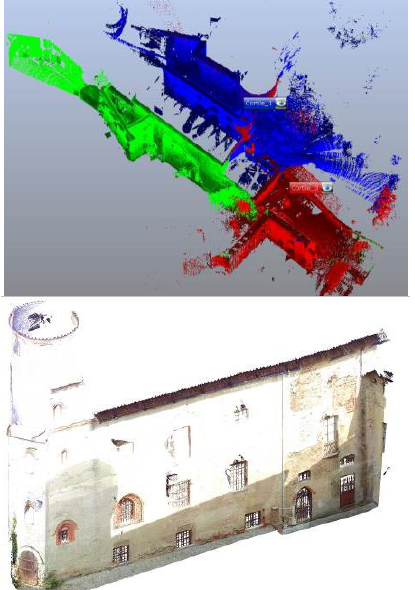
Figure 12 . (last page) the coloured Lidar Cloud of the test area. (above) the three block of clouds used for registration (below), the LiDAR model used for next comparison.